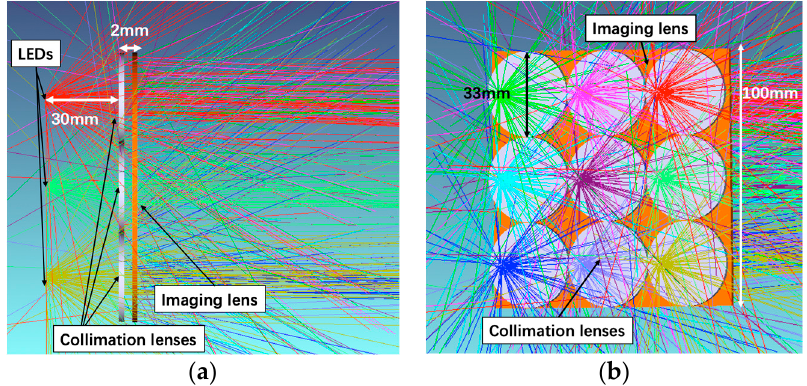
Figure 5. Lens system design of 3 × 3 LEDs array OWPT: ( a ) view from side; ( b ) view from LED chip.